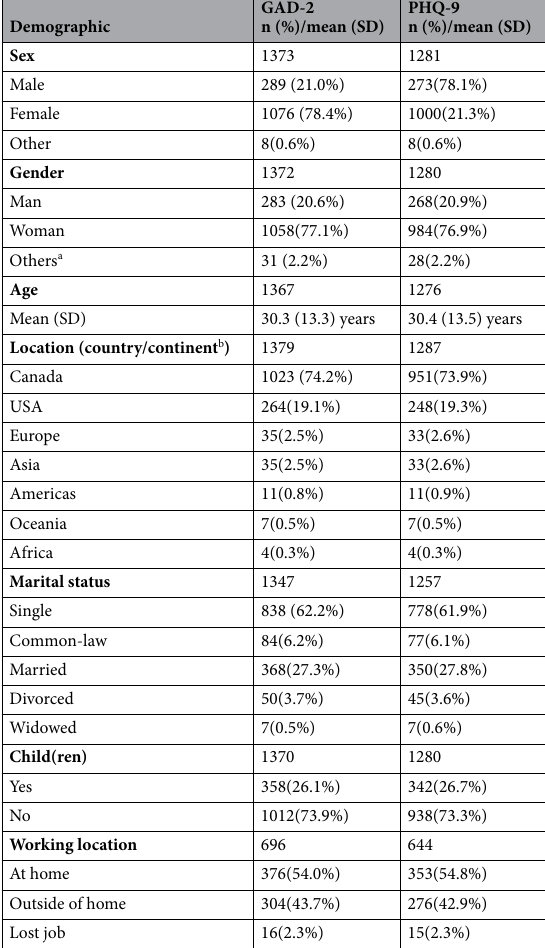
Table 1. Demographic characteristics. a Other genders includes participants who responded: